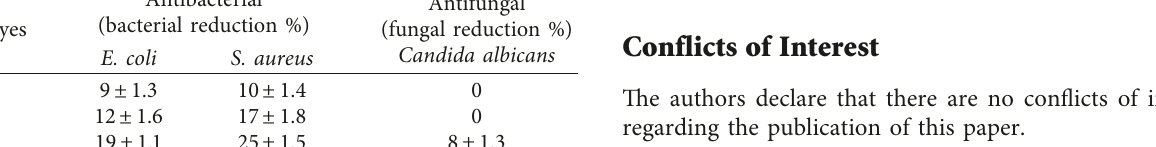
Table 3: Antimicrobial properties of dyestuffs 1 – 3 . Antibacterial (bacterial reduction %) Dyes